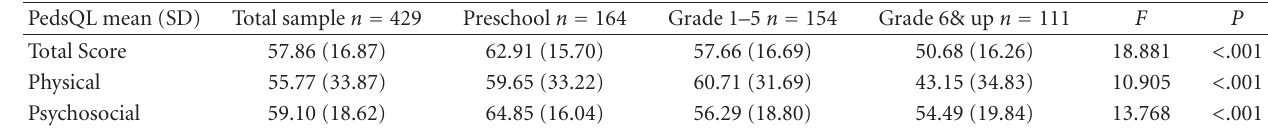
Table 3: Child Quality of Life scores.